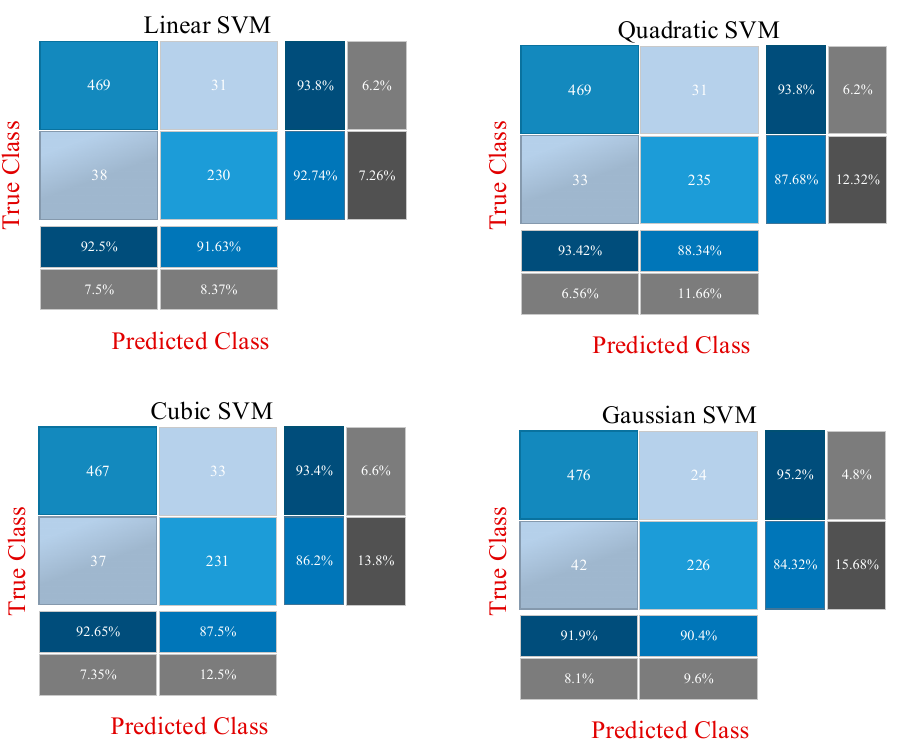
Figure 9. Training and loss graphics of ResNet models. ( a ) ResNet18. ( b ) ResNet50.